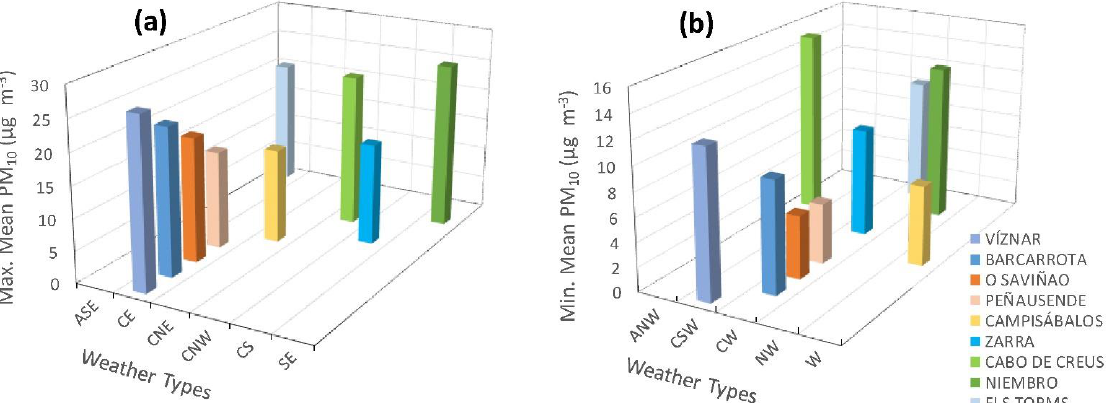
Figure 7. Distribution of the weather types related to maximum ( a ) and minimum ( b ) mean PM 10 for the period 2005–2019. Each color indicates a single station. Only weather types with the maximum or minimum values have been represented.